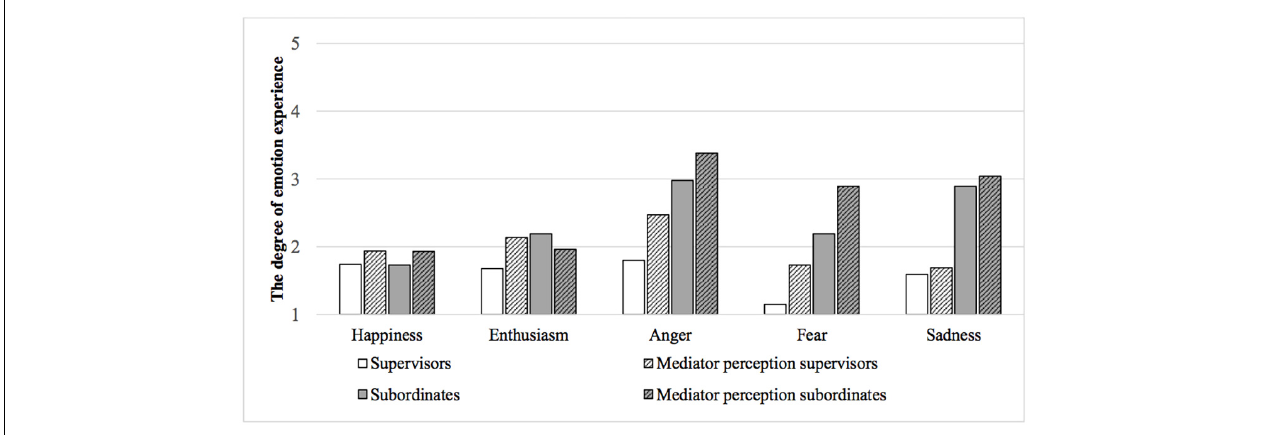
FIGURE 2 | Hierarchical position, experience of independent emotions and mediators’ perceptions of independent